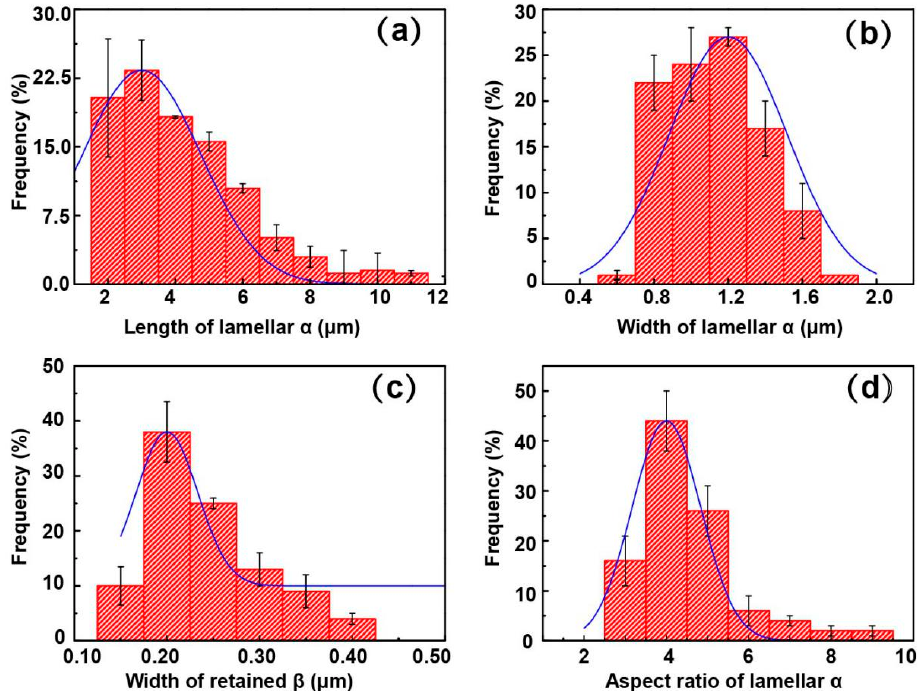
Figure 7. Distribution of microstructural features of TC4F Sample 3 after treatment. ( a ) Length of lamellar α , ( b ) width of lamellar α , ( c ) width of retained β , and ( d ) aspect-ratio distribution of lamellar α . Microstructural features followed Gaussian distribution. Most probable values of α length, width, aspect ratio, and retained β were ~2, ~0.45, ~4, and ~0.20 µ m, respectively.